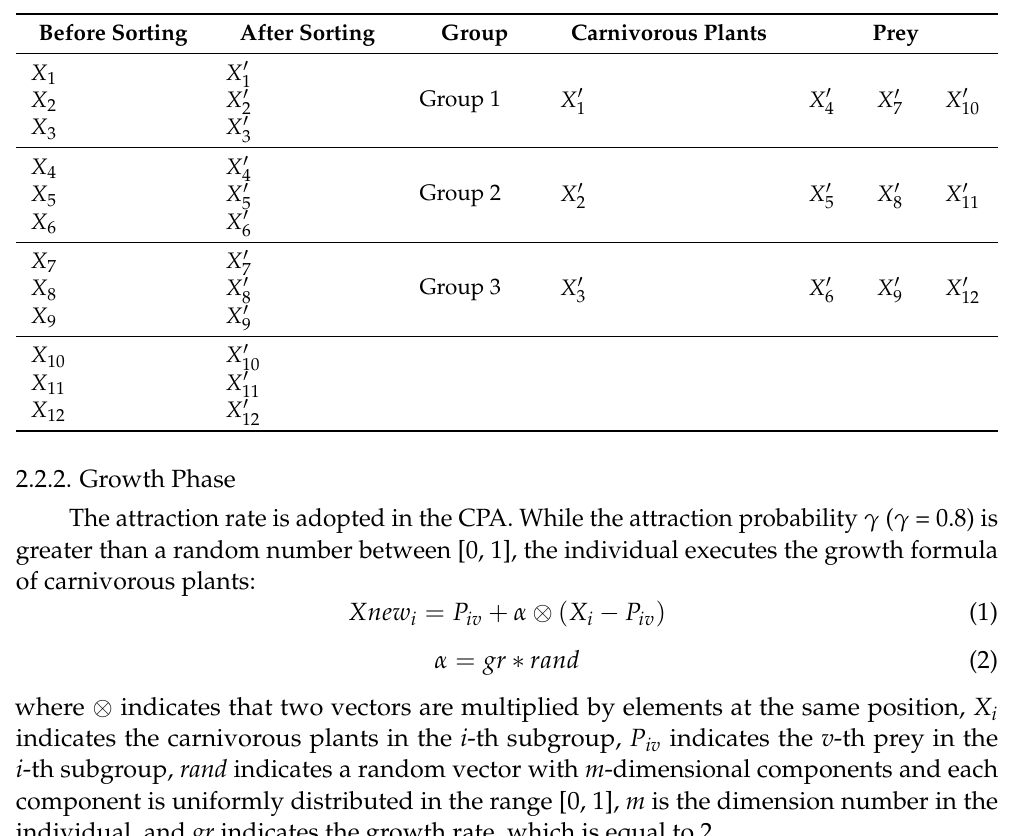
Table 1. The grouping process at size 12 in the